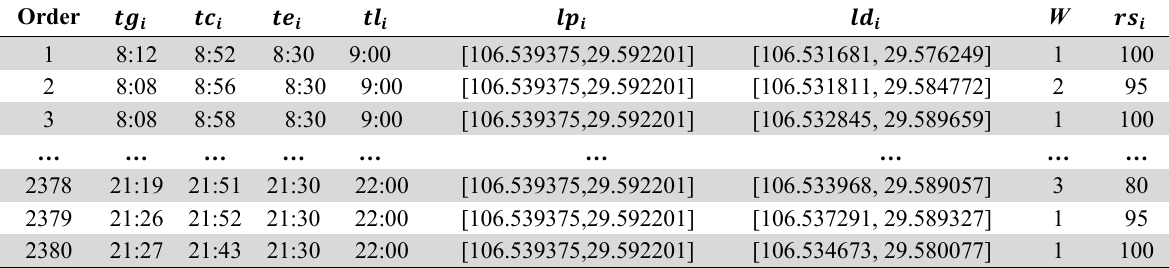
Fig. 4. The framework of the adaptive local search